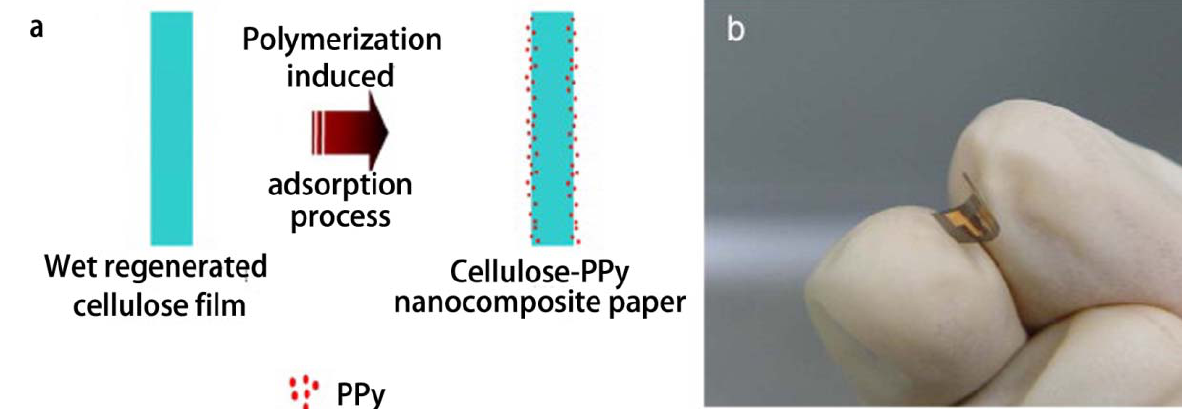
Figure 14. ( a ) Schematic of cellulose-PPy nanocomposite fabrication process; ( b ) Fabricated flexible humidity and temperature sensor. Reprinted with permission from [92]. Copyright 2010